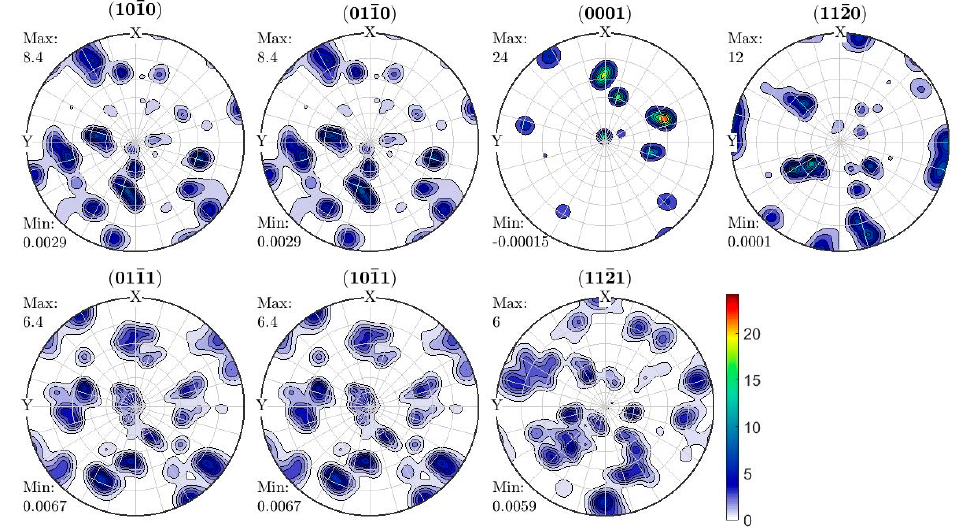
Figure 8. The (101(cid:3364)0), (011(cid:3364)0),(0001), (112(cid:3364)0),(011(cid:3364)1), (101(cid:3364)1) and (112(cid:3364)1) PFs of the α -phase for samples B.